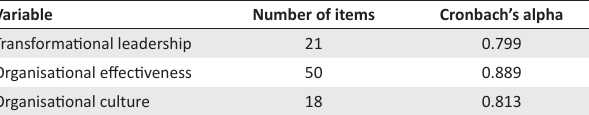
TABLE 3: Cronbach’s alpha scores for transformational leadership, perceived organisational effectiveness and organisational culture.